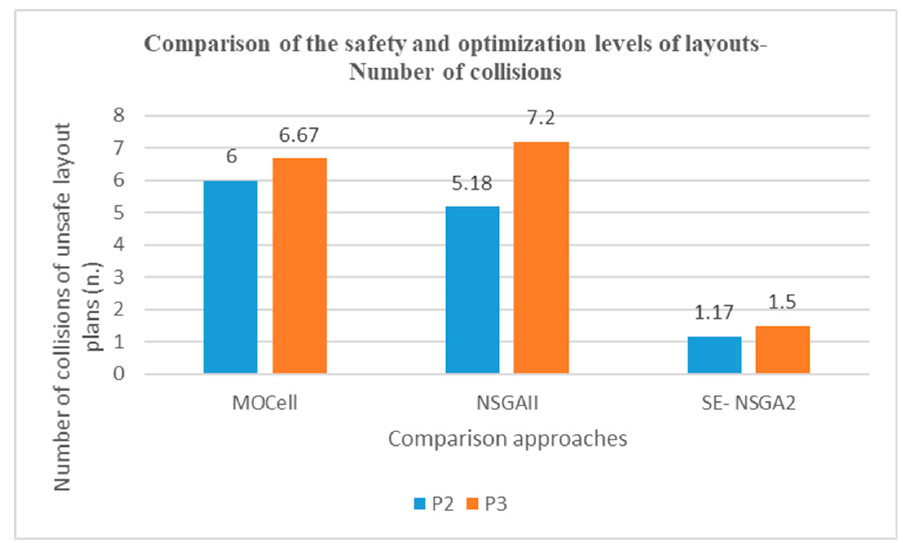
Figure 6. Comparison of the safety and optimization levels of layouts.